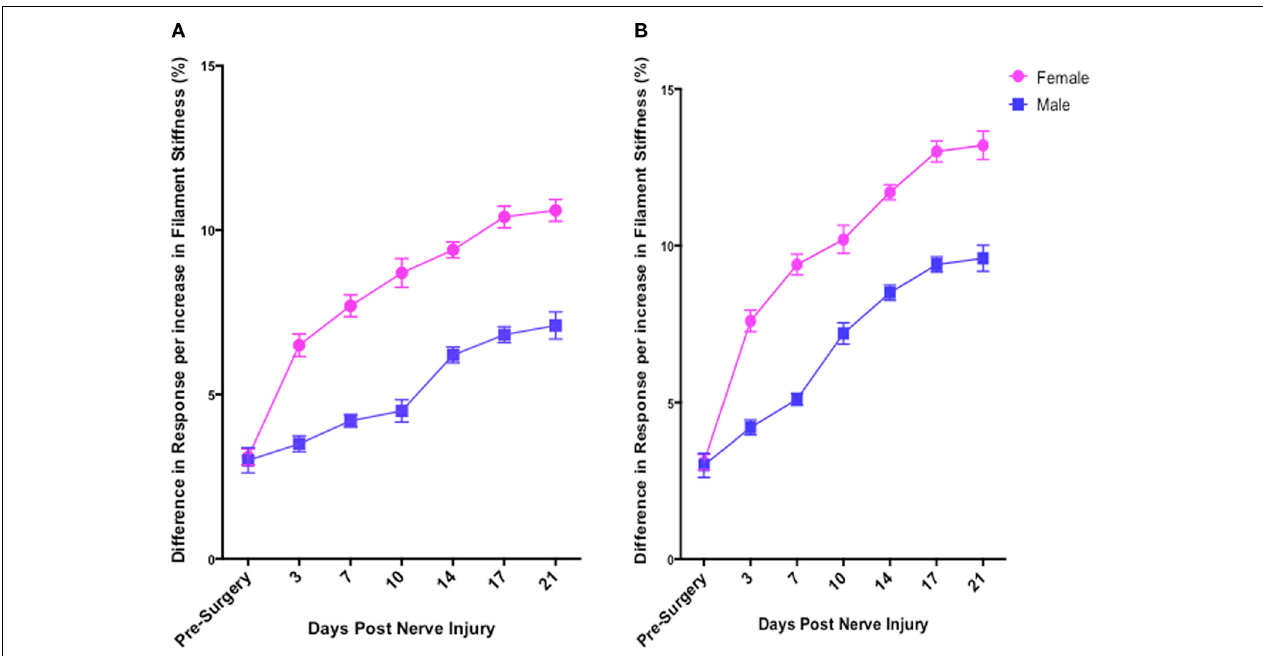
FIGURE 3 | von Frey test 3: a behavioral technique refining the investigation of the role of sex and rodent oestrus cycle in mechanical hypersensitivity. Through to 21 days following nerve injury, von Frey Test 3 was the sole behavioral testing method examined that identified a contributing role of sex and oestrus cycle in female mechanical allodynia examined in the graded nerve injury model. N1S3 females were found significantly more allodynic than matched males